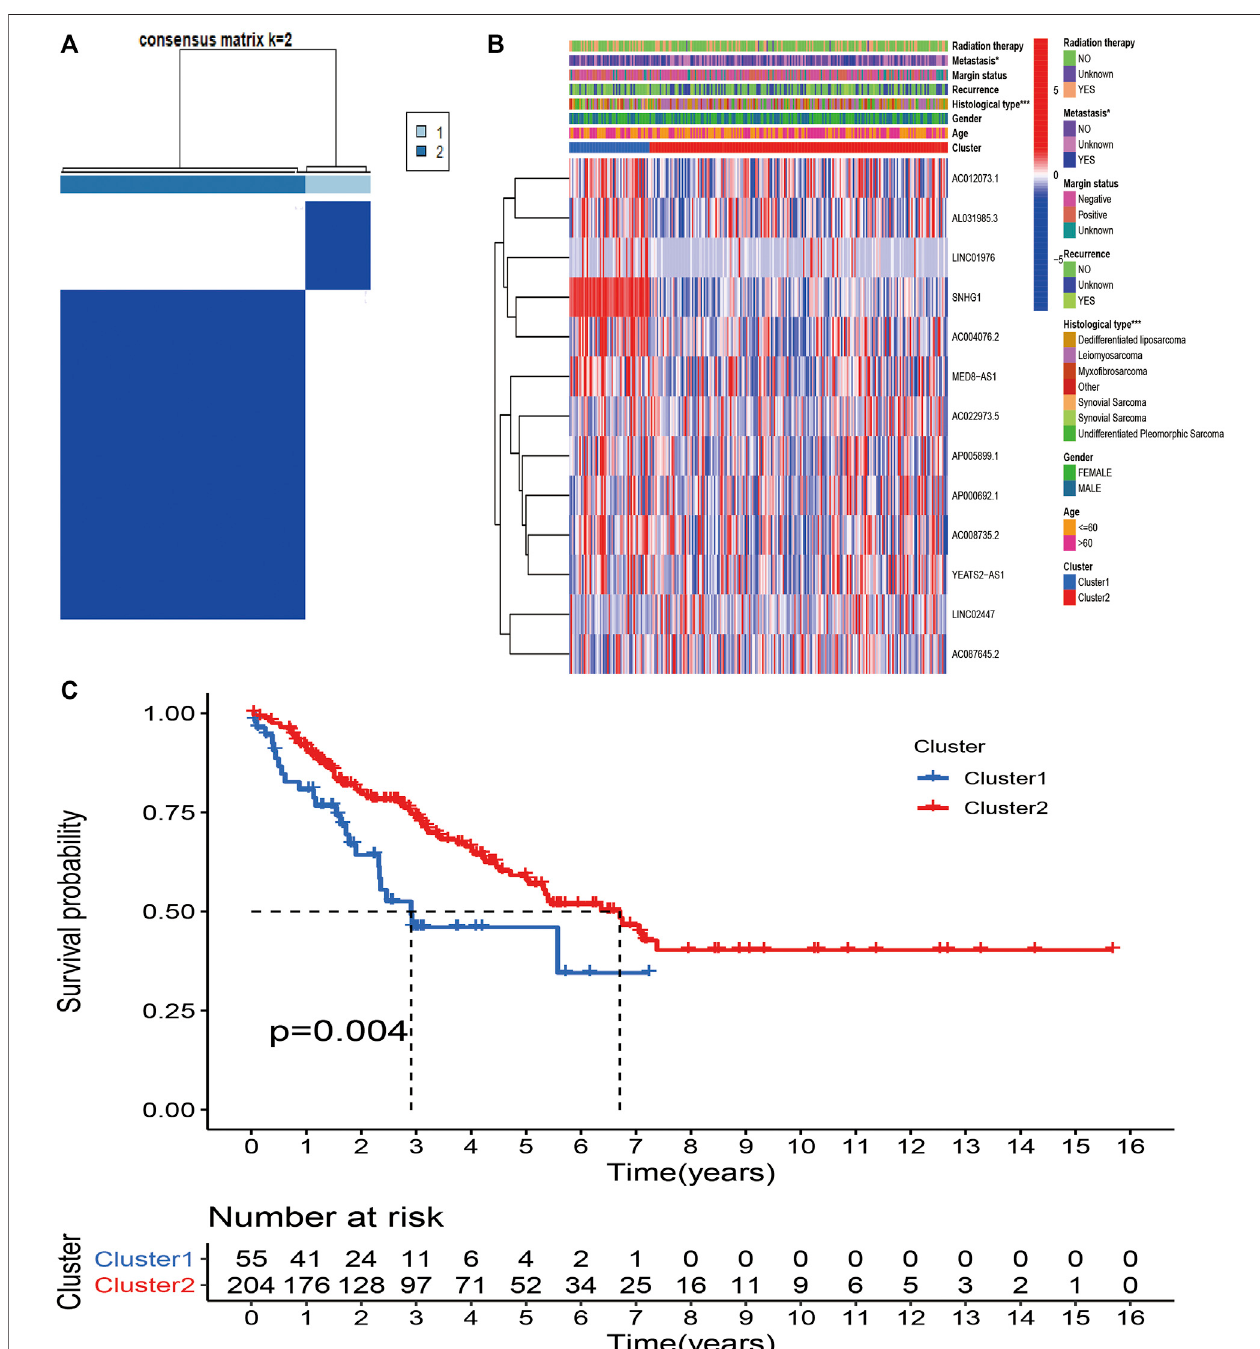
FIGURE3| ConsensusClusteringbasedonm6A-relatedlncRNAsinSTS. (A) Consensusclusteringmatrixfork (cid:1) 2. (B) Heatmapandclinicopathologicfeaturesof the two clusters (cluster1/2). (C) Kaplan – Meier analysis of patients in cluster 1 and cluster 2 subgroups.